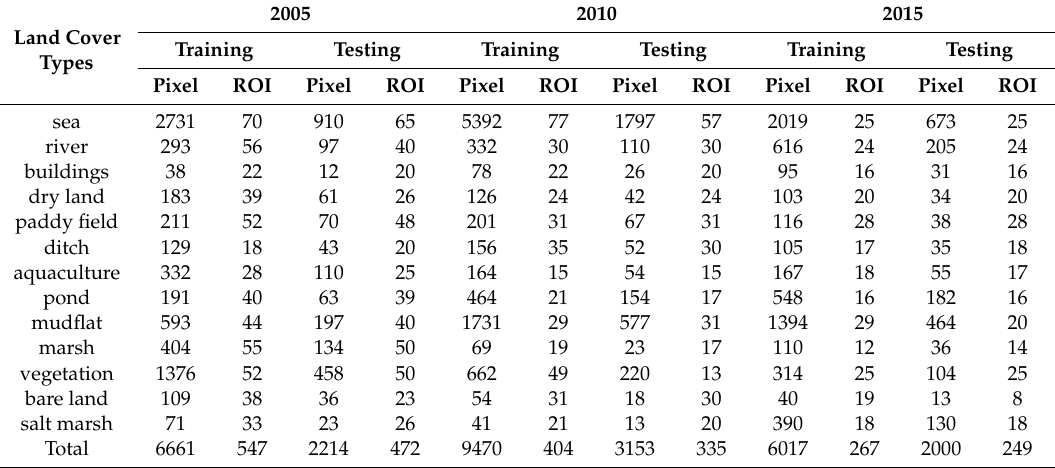
Table 3. Training and testing samples of each land cover type for Yellow River estuary Landsat data. Land Cover